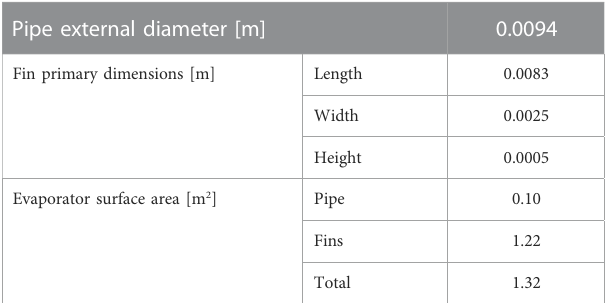
Figure 1A, which is attributed to the involved manufacturing process; the mechanical action of rolling/bonding the fi n strip shown in Figure 2C.